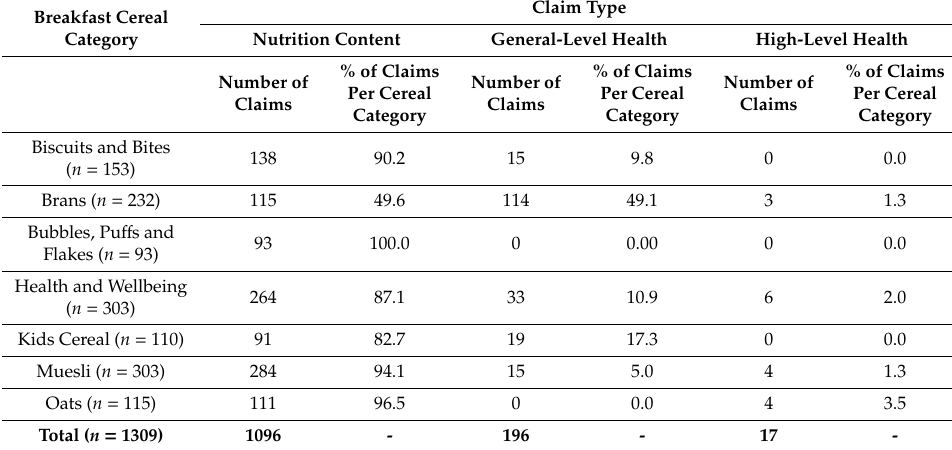
Table 2. Number and proportion of claim types found to be carried across breakfast cereal categories in the supermarket